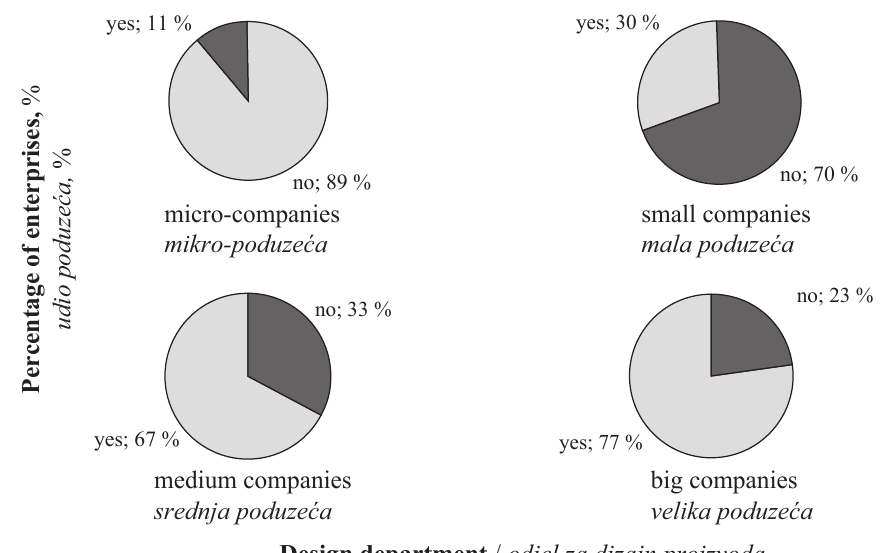
Figure 1 Structure of analysed furniture enterprises depending on the existence of a design department